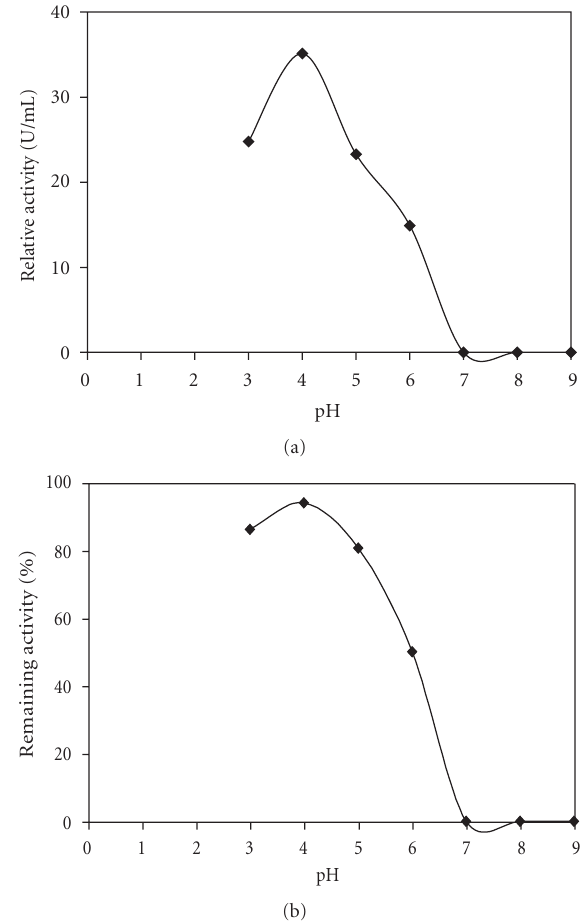
Figure 4: E ff ect of pH on the activity (a) and stability (b) of the extracellular proteases of A. niger I1 strain. pH optima were determined by incubating the crude enzyme with the substrate at di ff erent pH values at 60 ◦ C. The maximum activity obtained at pH 3.0 with hemoglobin as substrates was considered to be 100%. The pH stability was determined by incubating the crude enzyme in di ff erent bu ff ers for 1 h at 4 ◦ C, and the residual activity was measured at pH 3.0 and 60 ◦ C with hemoglobin as a substrate. The activity of the enzyme before incubation was taken as